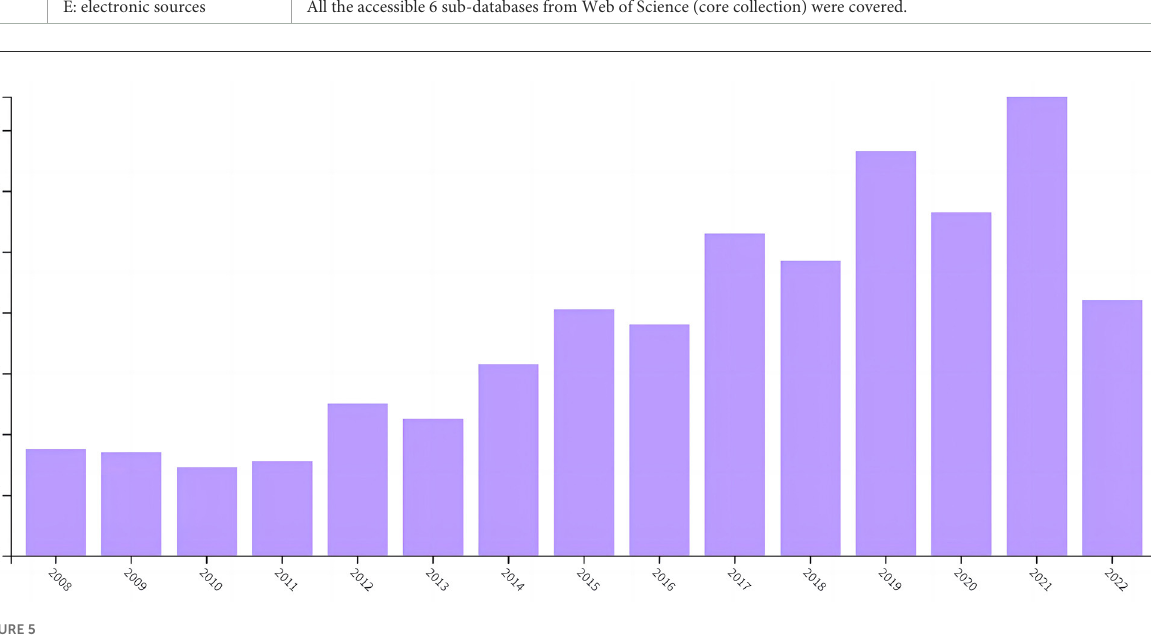
FIGURE5 The number of publications on academic